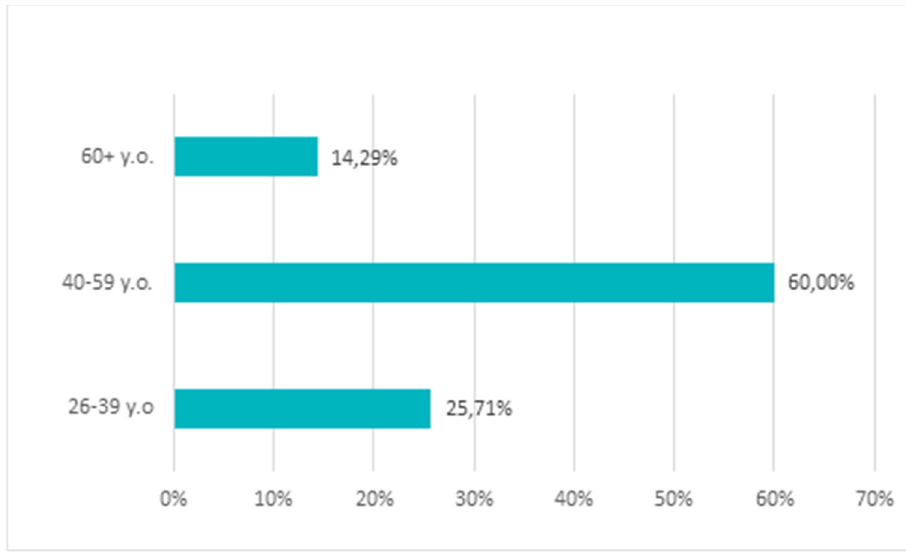
Figure 9. Age distribution of survey respondents.